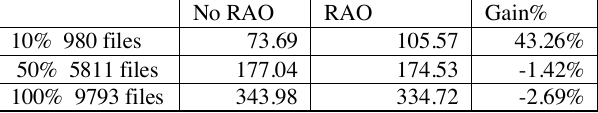
Table 5 RAO effects for small 1 GB none-aggregated files